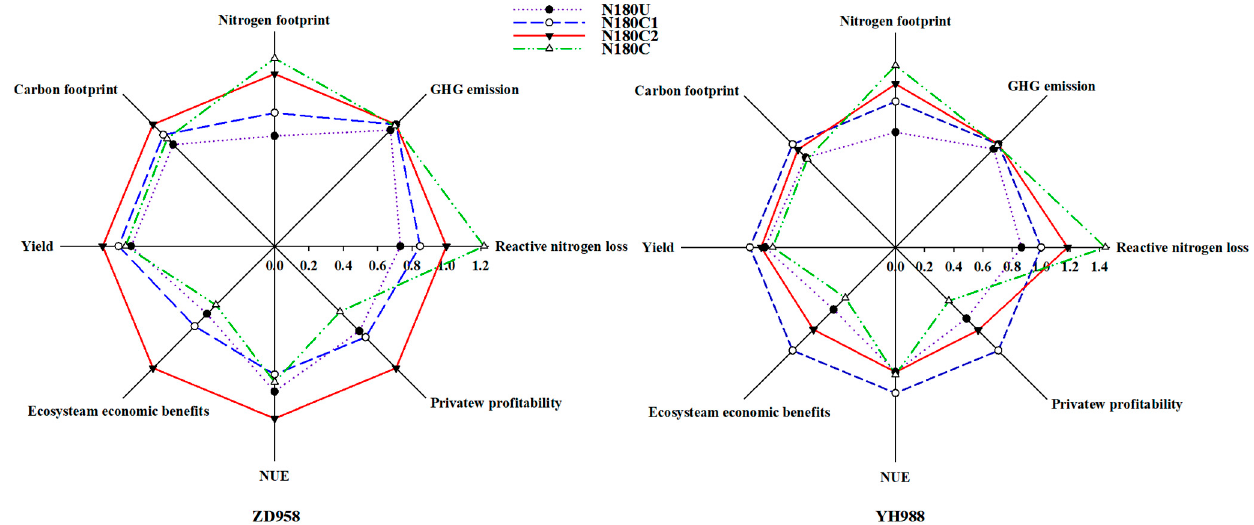
Figure 7. A radar char visualization of yield, NUE, environmental parameters (carbon footprint, nitrogen footprint, GHG emissions, reactive nitrogen loss), and cost parameters (private profitabil- ity and ecosystem economic benefits).